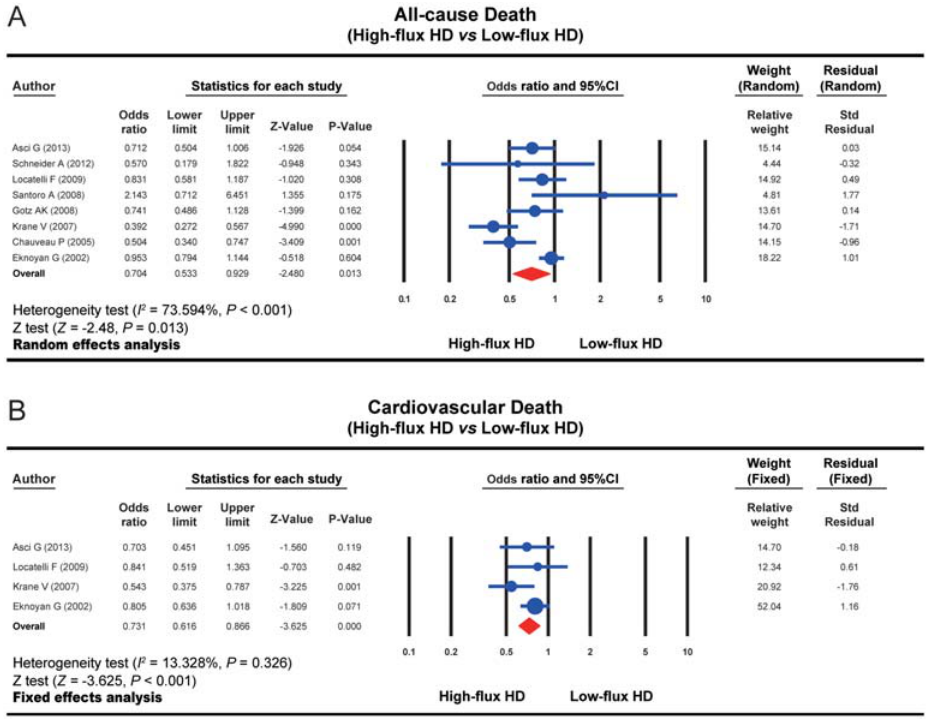
Figure 1. Forest plots of the in fl uence of high- fl ux hemodialysis and low- fl ux hemodialysis on the all-cause death rate and cardiovascular death rate of patients with chronic renal disease. HD: hemodialysis. See Table 1 for reference